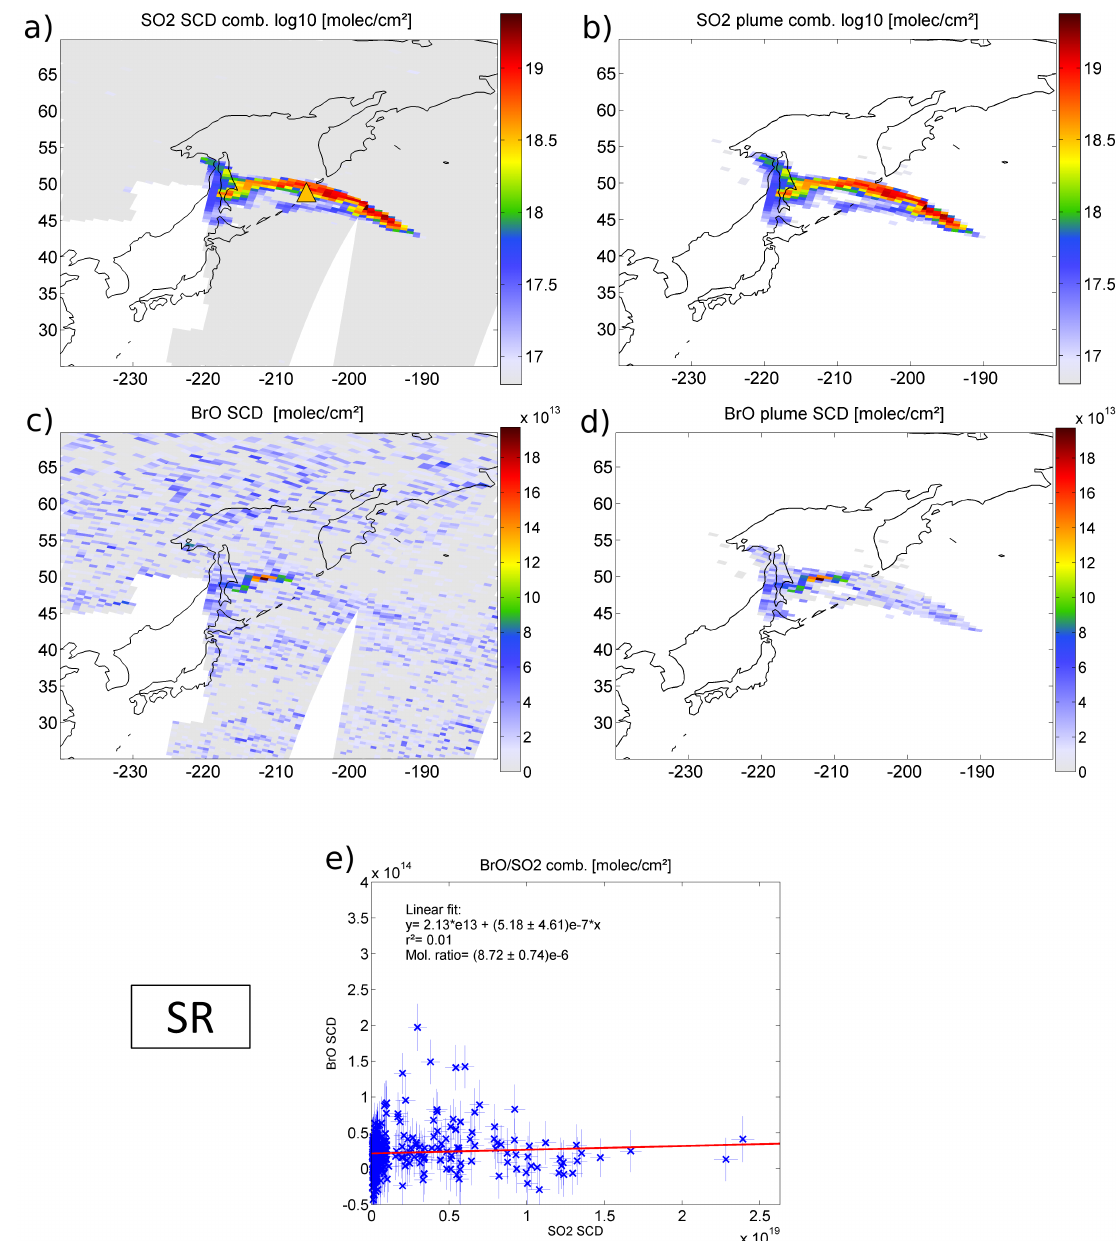
Fig. 13. The volcanic SO 2 and BrO plume during the eruption of Sarychev on 15/16 June 2009. The SO 2 plume ( a and b ) is transported in western and eastern direction from the volcano (indicated by the orange triangle in (a) ; the white area in the lower left corner is due to data restrictions in order to prevent the detection of anthropogenic SO 2 over China). Surprisingly, enhanced BrO columns are only observed in a fraction of the western part ( c and d ). The correlation plot for both species, therefore, lead to an r 2 value close to zero from the bivariate linear fit